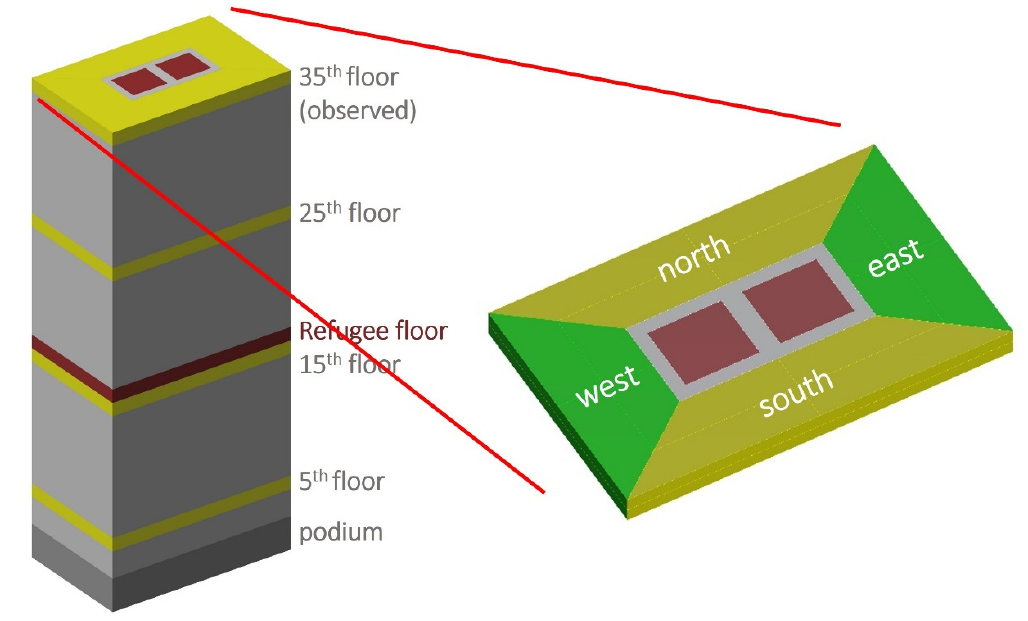
Figure 4. Illustration of the four sampled zones of the office space to be simulated.